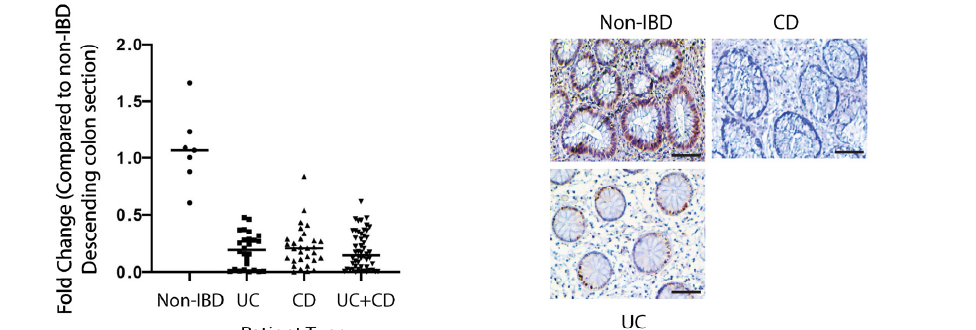
Figure 1. RASSF1A is epigenetically silenced in inflammatory bowel disease (IBD). ( A ) The methylation percentage of the individual CpGs in the RASSF1A promoter in inflammatory bowel disease patients, n = 80, and 14 control blood samples. The individual CpG methylation percentage indicates what percentage of DNA molecules are methylated at this site in the sample. Circled region corresponds to a hot spot in CRC patients [42]. ( B ) Immunohistochemical staining for RASSF1A in descending colon sections of IBD patients reveals loss of expression in IBD, confirming methylation data in ( A ). Left panel, summary of fold change in IHC staining of tissue sections; right panel, representative sections for each patient category. p value < 0.001 for difference between UC/CD/UC+CD vs. non-IBD (n = 10 for non-IBD and 26 for UC, 32 for CD, and 58 for UC+CD).